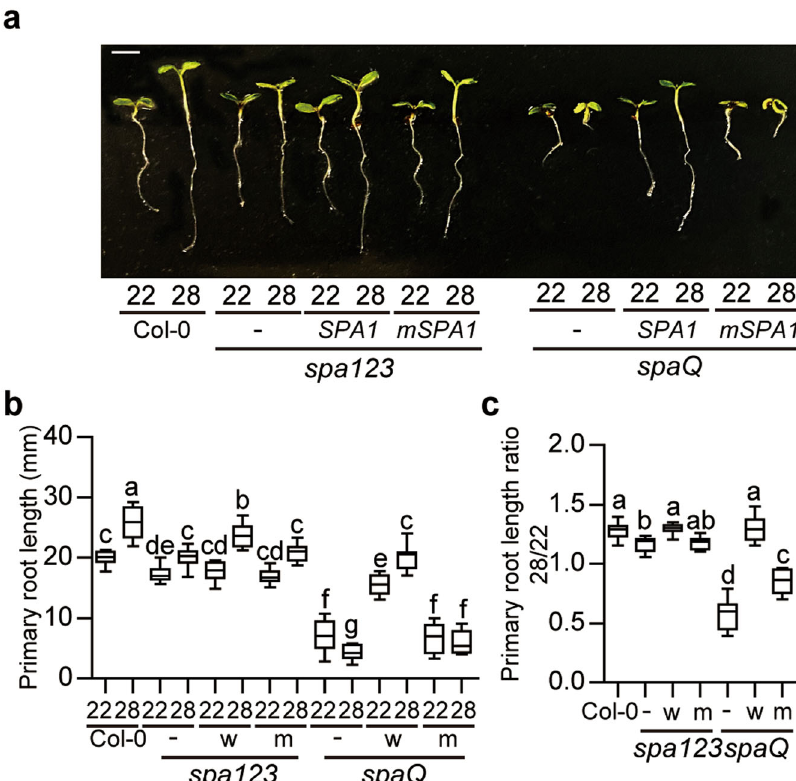
Fig. 5 SPAs are necessary for root thermomorphogenesis. a Photograph shows the seedling phenotypes of Col-0, spa123 , 35S:LUC-SPA1 / spa123 , and 35S: LUC-mSPA1 / spa123, spaQ , 35S:LUC-SPA1 / spaQ , and 35S: LUC-mSPA1 / spaQ at 22 °C and 28 °C. Three spa background plants are indicated with — for spa123 or spaQ , SPA1 for 35S:LUC-SPA1 overexpression line, and mSPA1 for 35S:LUC-mSPA1 overexpression line, respectively. Seedlings were grown for two days in continuous white light at 22 °C and then either kept at 22 °C or transferred to 28 °C for additional 5 days before being photographed. The scale bar represents 2 mm. b , c Bar graph shows the primary root lengths ( b ) and the root length ratio ( c ) for seedlings grown under conditions described in ( a ). w, wild-type SPA1 and m, mSPA1, respectively. For the length ratio 28/22, the primary root length at 28 °C was divided by that at 22 °C. The letters a – f indicate statistically signi fi cant differences between means of primary root lengths ( n = 15, P < 0.05) based on one-way ANOVA analyses with Tukey ’ s HSD test. For the box and whisker plots in b , c , the boxes represent from the 25th to the 75th percentile and the bars equal the median values. The source data underlying the root measurements ( b , c ) are provided in the Source data fi